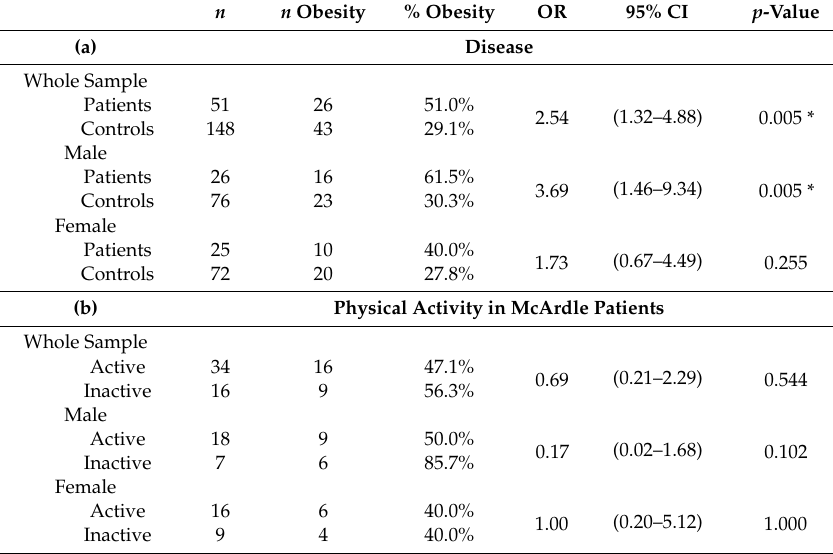
Table 5. Association between McArdle disease and obesity ( a ), and physical activity and obesity only in McArdle patients ( b